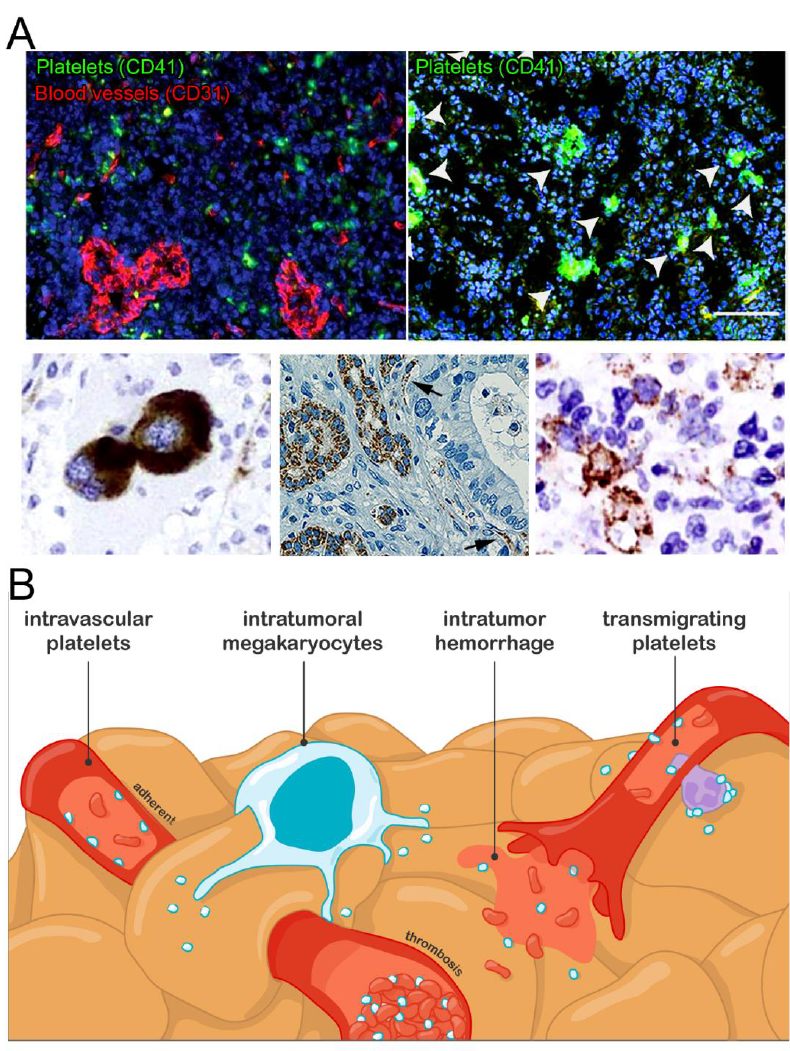
Figure 1. Intratumoral platelets: occurrence and possible origins. ( A ). Images of the different types of intratumoral platelet localization and interactions reported: perivascular aggregates (upper left panel, mouse ovarian cancer), aggregates with tumor cells (upper right panel: mouse glioma, platelet aggregates are indicated by white arrows, scale bar = 100 µ m; bottom right panel: colorectal cancer), intravascular platelets (black arrows, lower middle panel: human pancreatic cancer), and intratumor megakaryocytes (lower left panel: human renal cell carcinoma). Adapted with permission from Refs. [109,119,126,130,131]. Copyright 2016, American Society for Clinical Investigation;